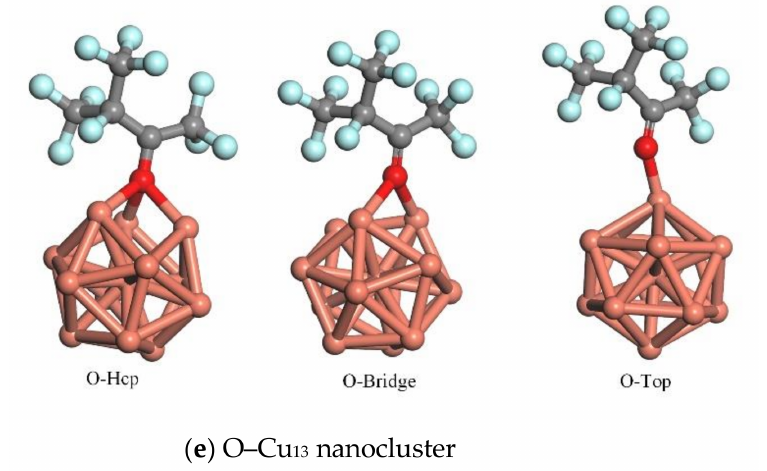
Figure 8. Simulation results of the reaction process between C 5 F 10 O and